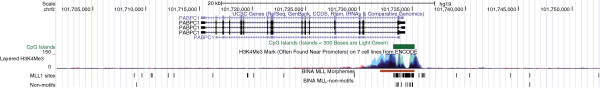
Zoom-out view of morpheme occurrences in PABPC1 locus. Horizontal green bar marks the position of CGIs. Horizontal brown bar marks the chromatin segment bookmarked by MLL1 during mitosis [31]. Track-labeled “MLL1 sites” marks morpheme positions; “non-motifs” mark the position of sequences not found in results of SELEX assays [24]. Track labeled “Layered H3K4me3” shows the position of H3K4me3 marks [59].